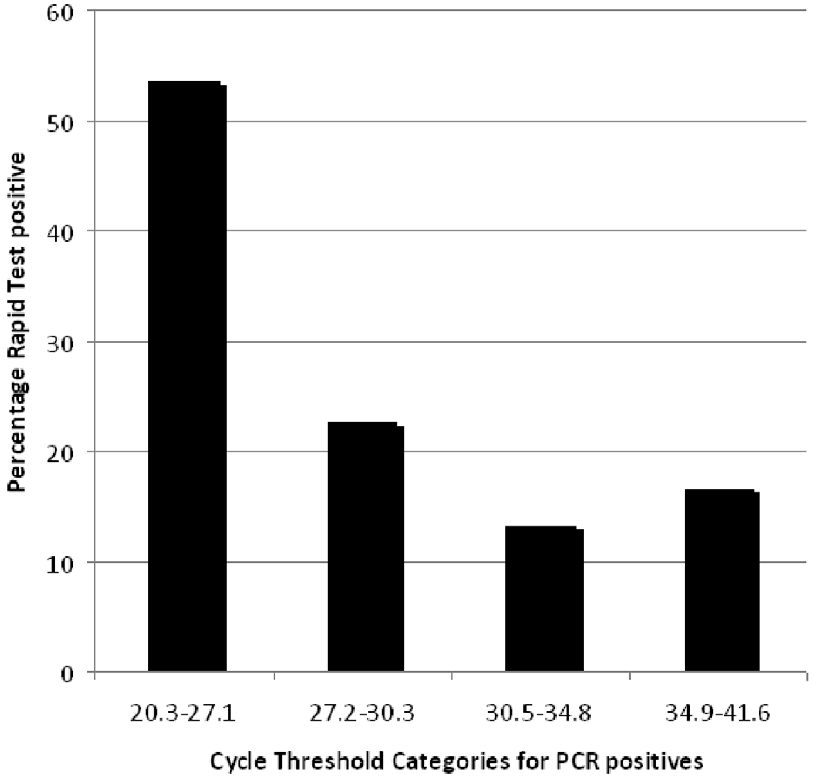
Figure 2. The numbers of specimens with a positive RIDT result were determined within four intervals of cycle threshold (Ct) values: 20.3–27.1, 27.2–30.3, 30.5–34.8, 34.9–41.6 (quartiles of Ct values).